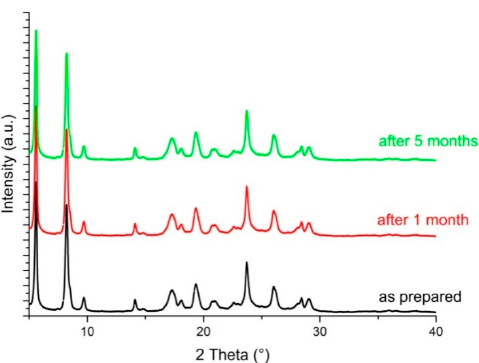
Figure 3. PXRD pattern of (+)-catechin tetrahydrate recorded as prepared (black line), after 1 month (red line) and after 5 months (green line).